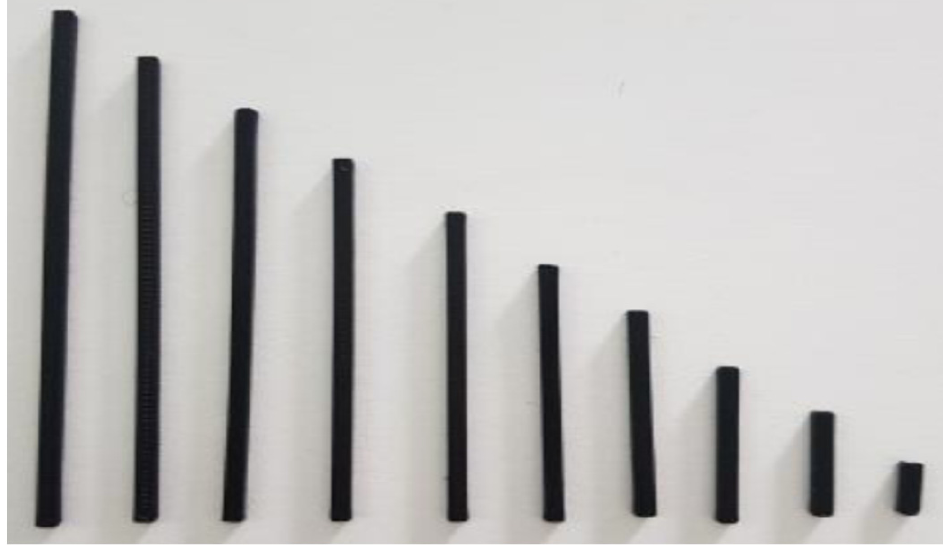
Figure 5. Specimens for resistance measurement, length from 10 mm to 100 mm.